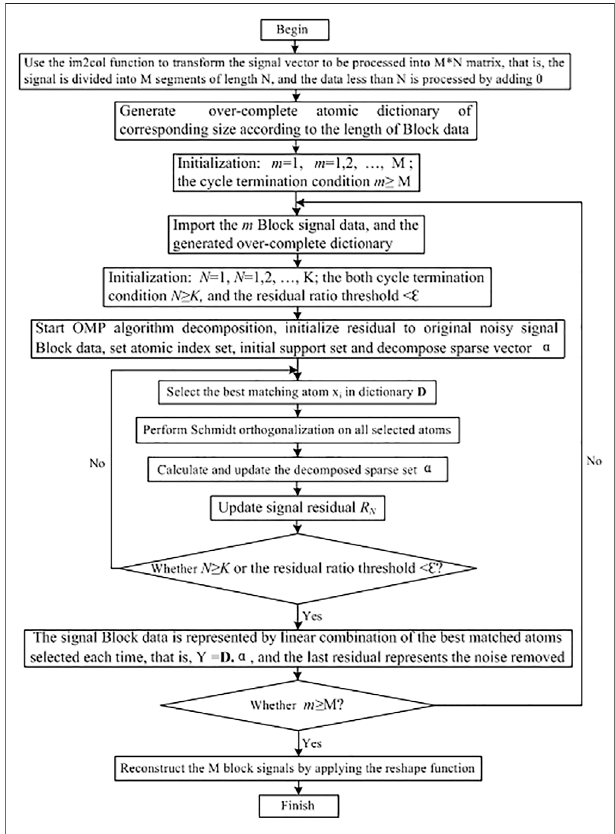
FIGURE 1 | Flow chart of the sparse decomposition algorithm based on block